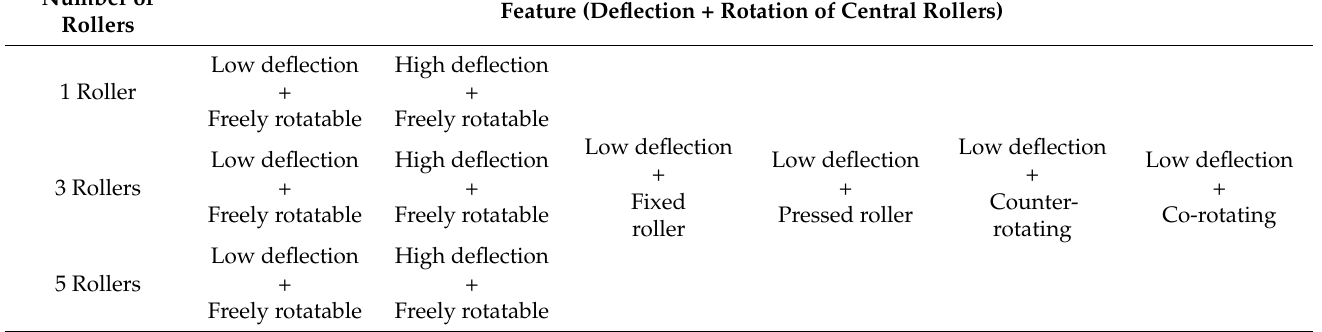
Table 3. Overview of processing parameters investigated.